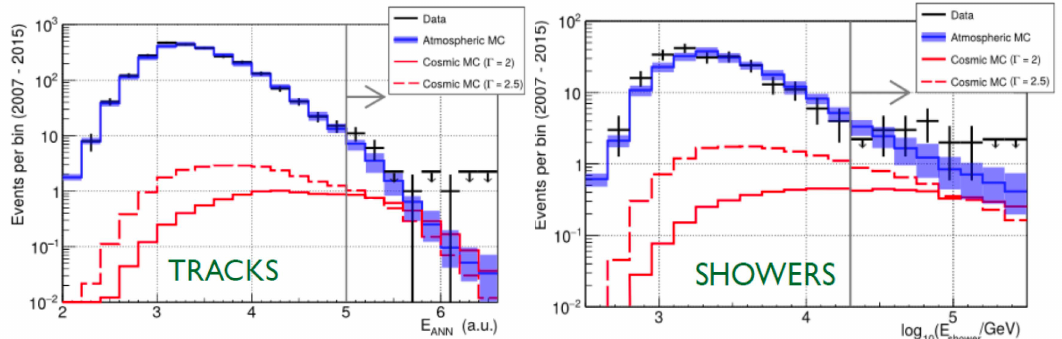
Figure 1. Event energy distributions of reconstructed events (black), Monte Carlo (MC) simulation of the expected atmospheric muon flux (blue), MC simulation of the expected cosmic neutrino flux (red). Left : track events. Right : shower events.